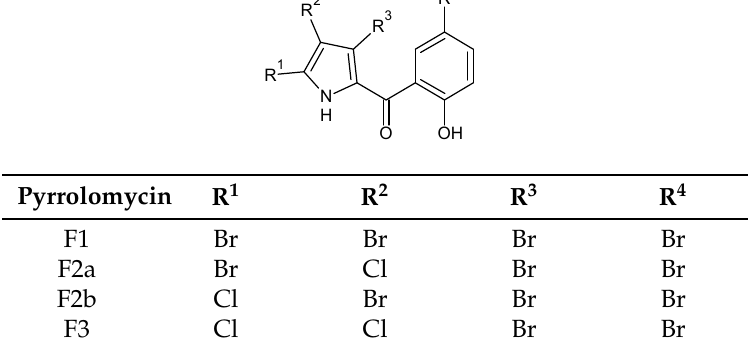
Figure 4. Chemical structures of pyrrolomycins F. Table 4. Antibacterial activities of PM-F reported as MIC ( μ M).